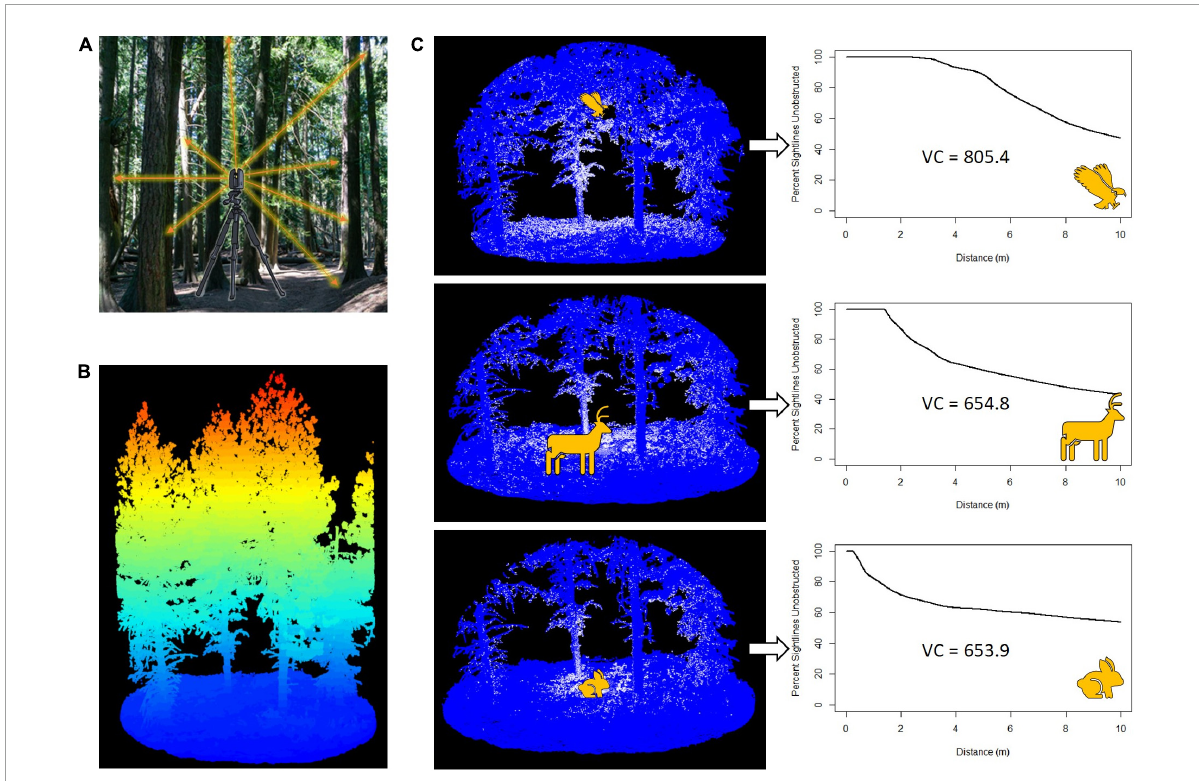
FIGURE3 Method for estimating viewsheds. (A) Terrestrial laser scanner (TLS) used to collect data from multiple locations within a plot. (B) Scans gathered using the TLS are stitched together to produce lidar point clouds representing the habitat structure of the entire plot. Displayed is a forest point cloud, in which the color ramp shows relative elevation from low (blue) to high (red). (C) Application of viewshed3d to the point cloud from three eye-heights (0.25, 1.5, and 5 m) representative of animal groups that access ecosystems from those heights. The white and blue dots are lidar data points; white points are those at the ends of measured sightlines. Viewshed graphs display the percent of unobstructed sightlines as a function of distance from the animal position. The viewshed coefficient (VC) is calculated as the area under the curve and is a measure of viewshed